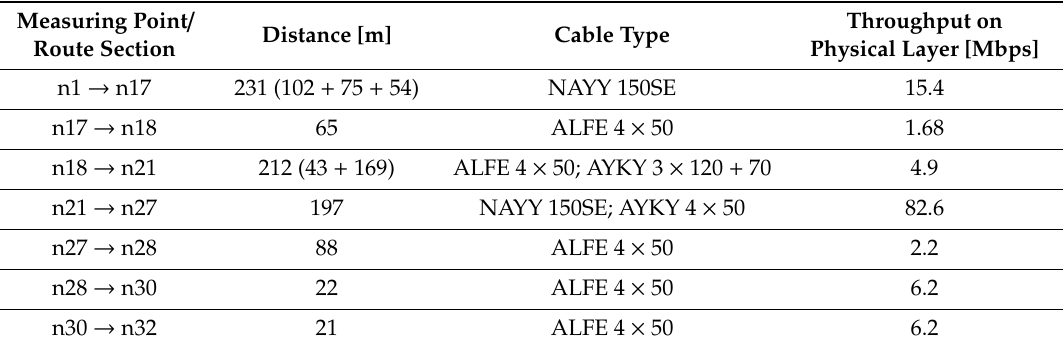
Table 1. Possibility of communication—without